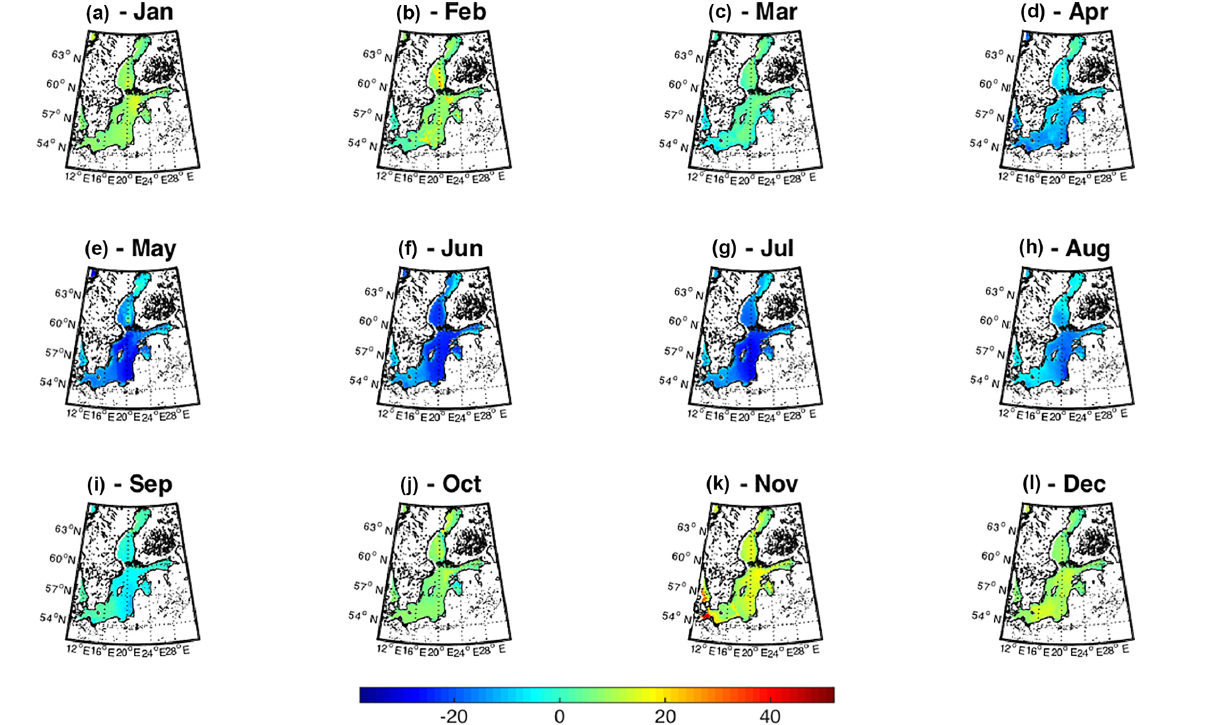
Figure 10. Temporal evolution of the air–sea CO 2 flux between 1998 and 2011 based on SMHIp